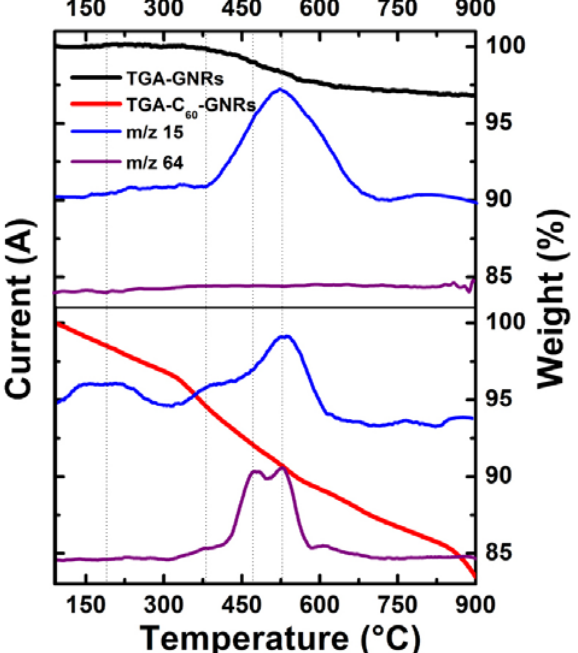
Figure 2 . Evolved gas analysis. Black and red curves represent the TGA profile of GNRs and C -GNRs respectively. Blue and purple 60 lines represent fragments with m/z fragments that correspond to m/z 15 and m/z 64,